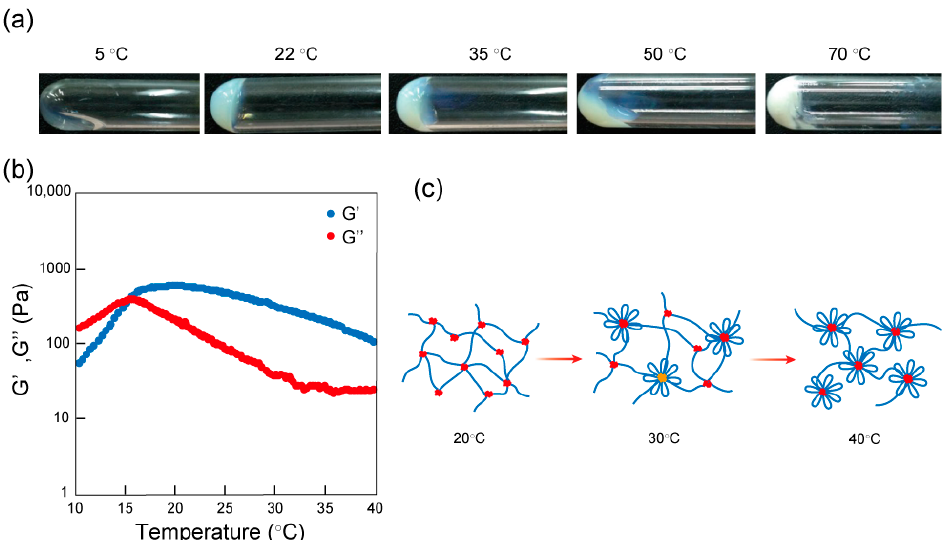
Figure 4. Temperature sensitivities of the hydrogels. ( a ) Photographs of poly-(NAAMe 53 - b -NAGMe 240 - b -NAAMe 53 ) aqueous solutions at various temperatures. [polymer] = 30 wt %. ( b ) Temperature dependence of the storage (G’) and loss (G”) moduli for poly(NAAMe 53 - b -NAGMe 240 - b -NAAMe 53 ) in the heating process from 10 °C to 40 °C at 6 rad·s − 1 , strain 1%. ( c ) Schematic illustration for a flower-like micelle network model of poly(NAAMe 53 - b -NAGMe 240 - b -NAAMe 53 ) between 20 °C and 40 °C corresponding to the plateau region of the turbidity curve in Figure 1.